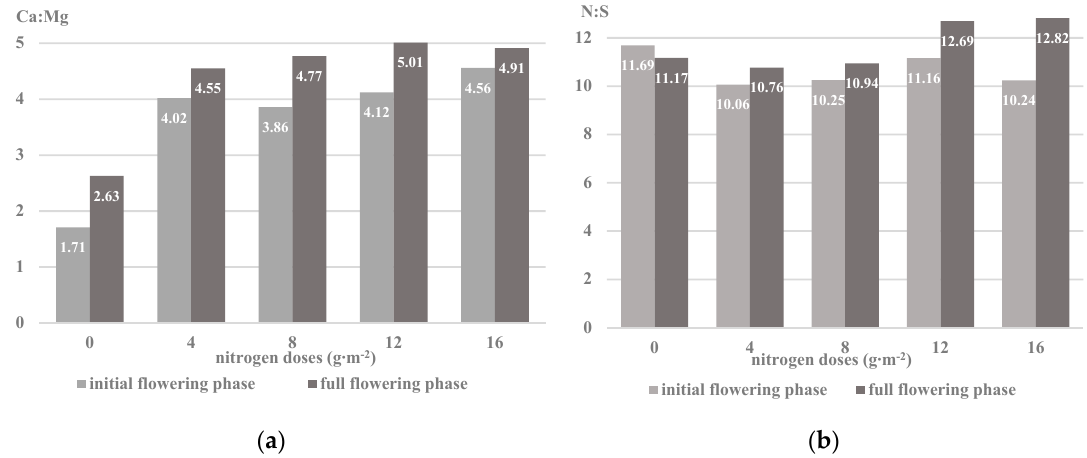
Figure 3. Ionic interaction of nutrients in the herb of the savory of Saturn cv. in the plant development phases depending on the dose of nitrogen: ( a ) ionic ratio between Ca and Mg ( b ) ionic ratio between N total and S (based on the mean for 2014–2016).